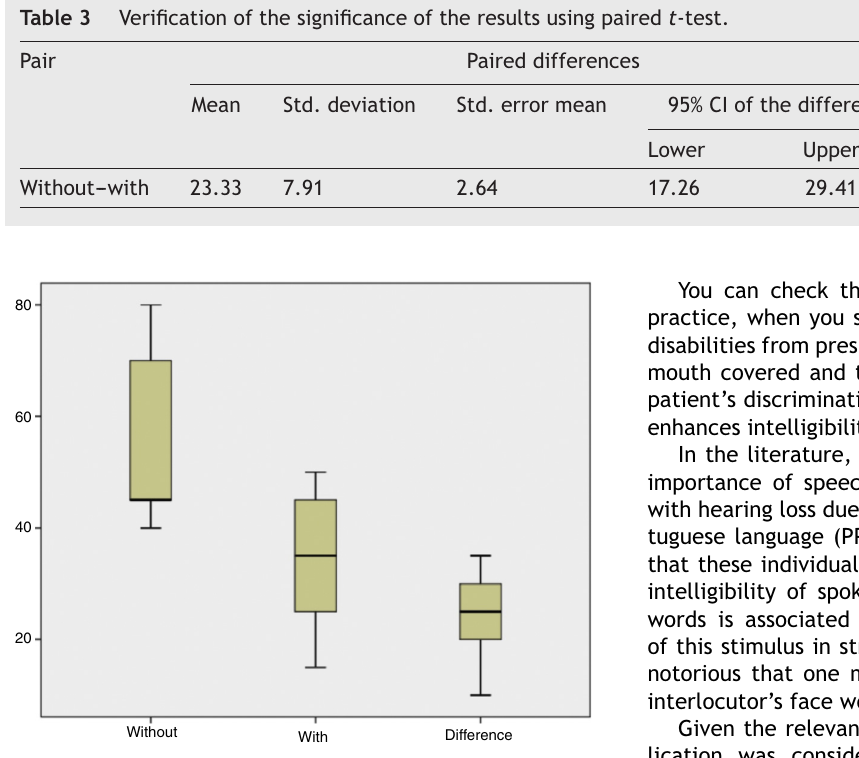
Figure 1 Box plots of data that display the variation in the